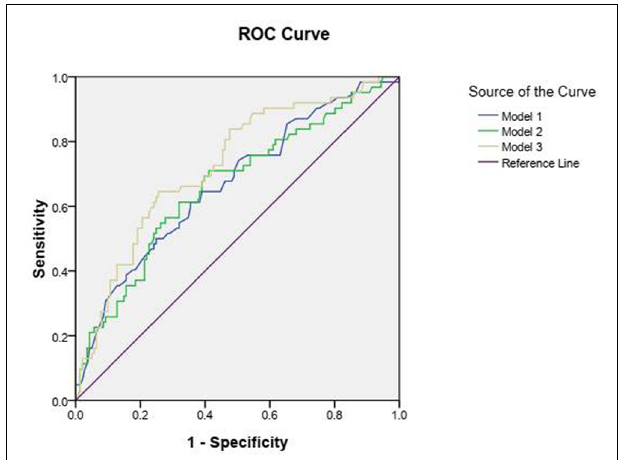
FIGURE 4 | Receiver Operating Characteristic (ROC) curve analysis of Model 1, Model 2, and Model 3. constructed based on traditional risk factors (area under the ROC curve = 0.668, P = 0.000; 95% CI = 0.587–0.749). Moreover,